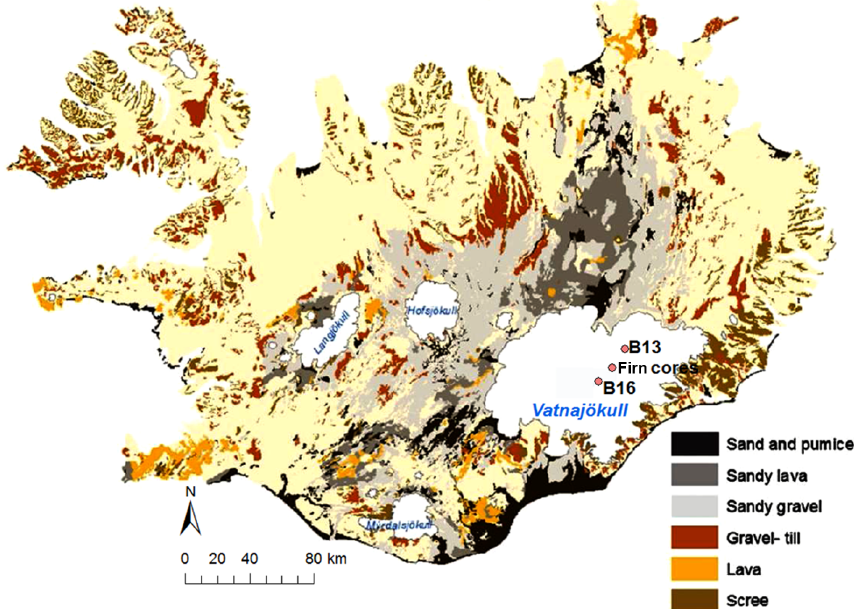
Figure 1. Iceland with glacier outlines and soil map adapted from Arnalds (2015). The two AWSs at B13 and B16 as well as the firn core drill site on Brúarjökull are